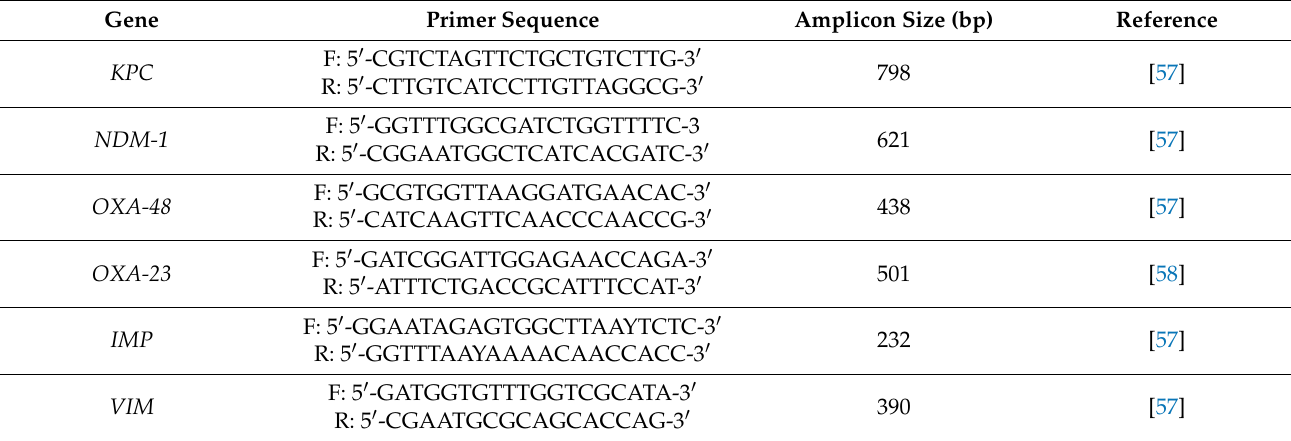
Table 8. Primer sequence and amplicon sizes (bp) for detecting carbapenem genes in K. pneumoniae